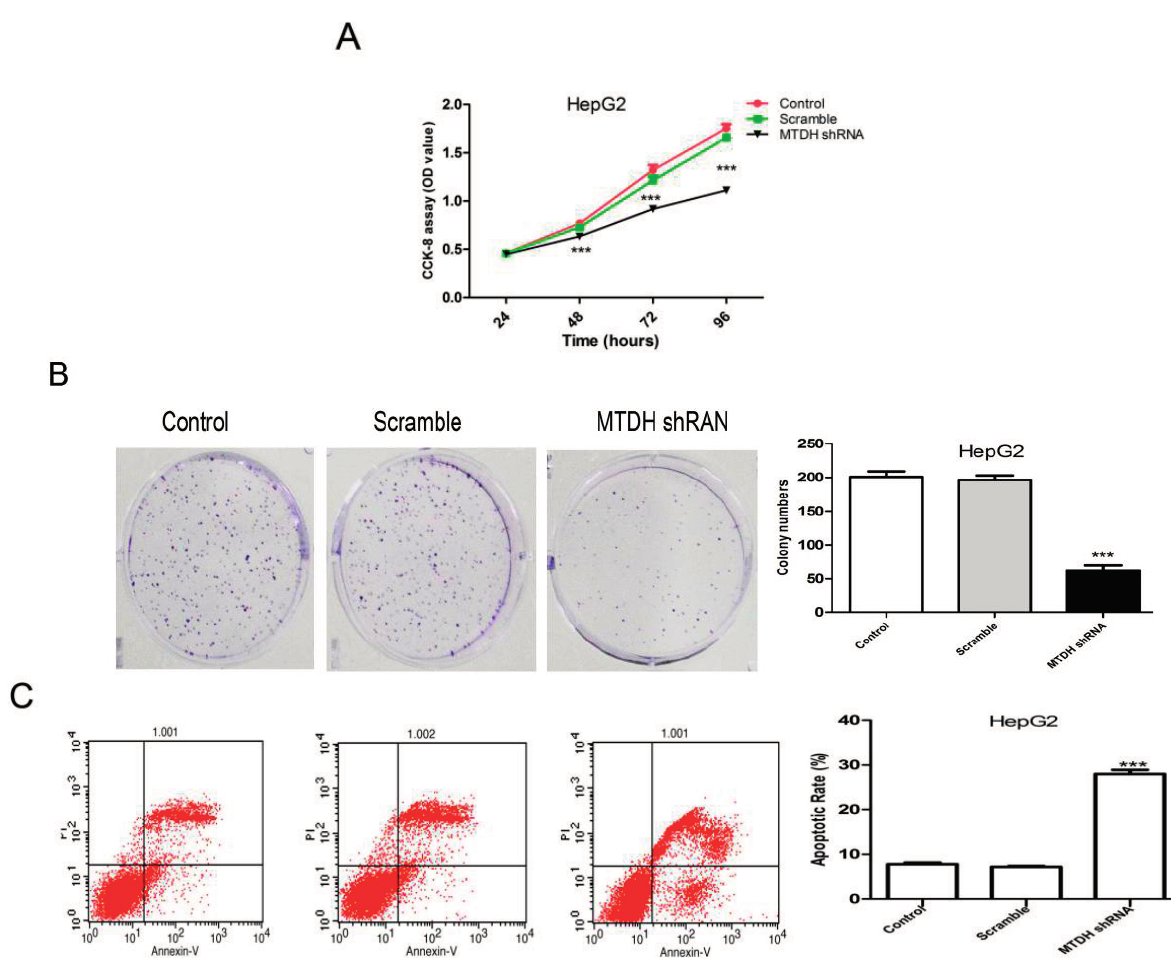
Figure 3. Effects of MTDH silencing on HepG2 cell proliferation and apoptosis. ( A ) CCK-8 to test cell proliferation; ( B ) Representative photographs of the colony formation